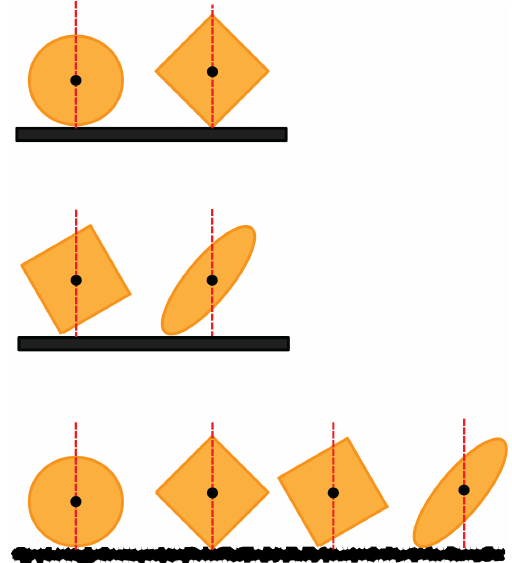
Figure 5. Illustration of collinear and non-collinear collisions for particles with center of mass depicted in black and line of collision depicted in red. Particle shape and orientation affects likelihood of collinear collision as does surface